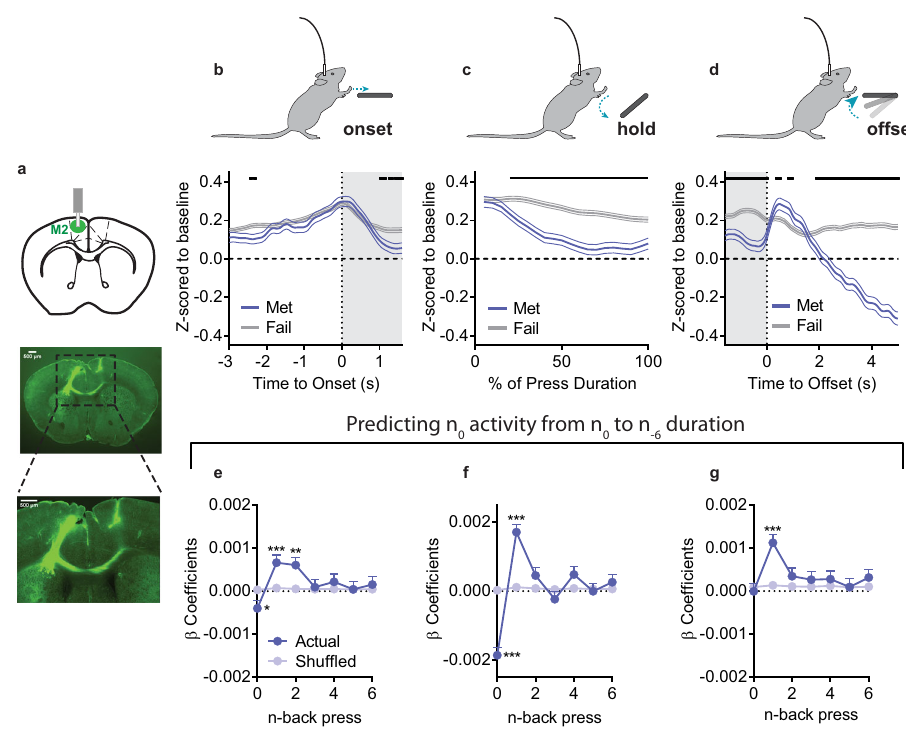
Fig. 4 M2 Ca 2 + activity re fl ects prior experience. a (top) Schematic and (bottom) example histology of M2 in vivo Ca 2 + fi ber photometry recordings. b – d Ca 2 + activity z-scored relative to a baseline period and aligned to ( b ) press onset, ( c ) the hold down period itself (presented as the relative % of a press ’ s duration), and ( d ) the offset of a lever press. e – g β coef fi cients from LME models relating activity to current and prior durations for Actual and order Shuf fl ed data ( e ) before press onset, ( f ) during the press, and ( g ) after press offset. Met = Presses that met criterion, Fail = Presses that did not meet criterion. Grey shading in ( b , d ) indicates 1.6 s. Black lines in ( b – d ) indicate signi fi cant differences between Met/Fail via permutation testing that required consecutive samples to pass the threshold for signi fi cance. All tests were two-tailed, and e – g were corrected for multiple comparisons. Shuf fl ed data are the mean + SEM of 1000 order shuf fl ed β coef fi cients. *** p < 0.001, ** p < 0.01, * p < 0.05. See also Supplementary Fig. 3, Supplementary Table 4, and Source (difference in simple/complex prediction %: Before Press: + 13.7%, During Press: + 9.2%, After Press: + 16.4%). Combined